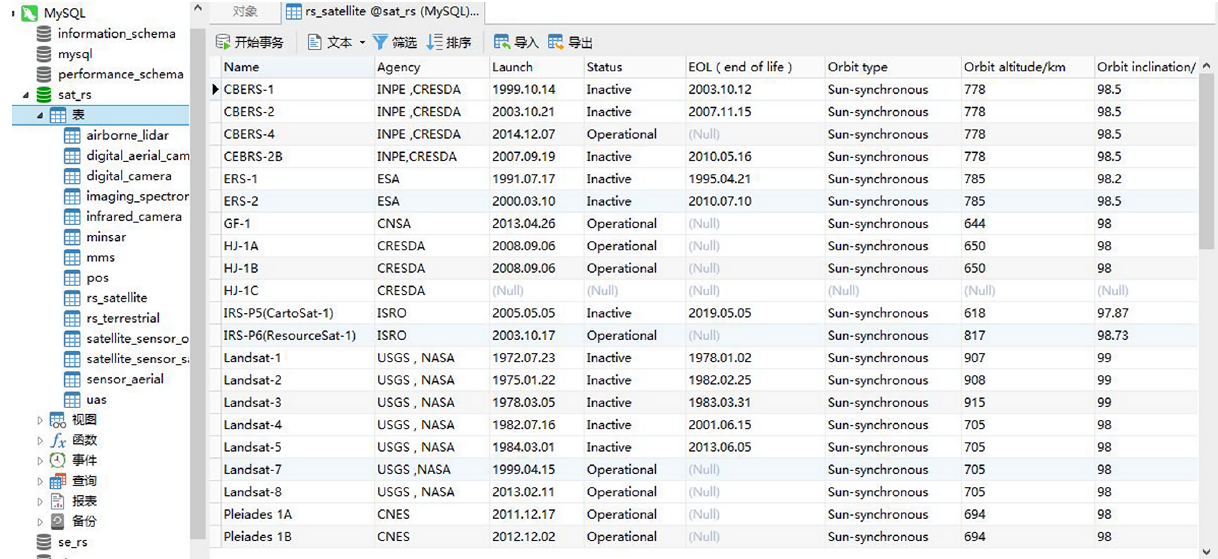
Figure 4. SAT_RS database (partial). CNES: Centre national d’études spatiales. CNSA: China National Space Administration. CRESDA: China Center for Resources Satellite Data and Application. INPE: Instituto Nacional de Pesquisas Espaciais. ISRO: Indian Space Research Organisation. USGS: United States Geological Survey.